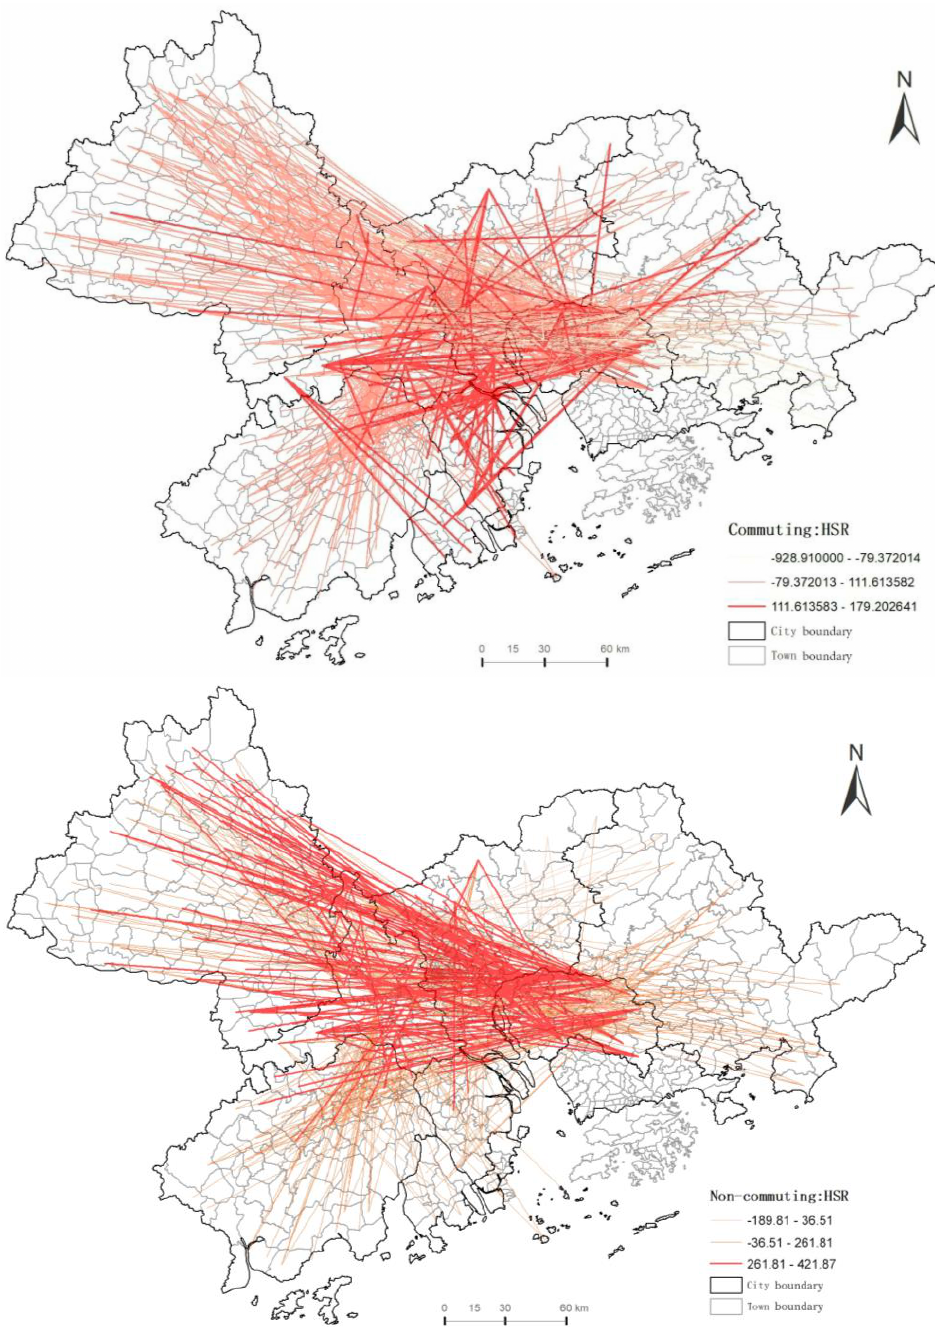
Figure 6. The local effect of HSR on rural mobility.